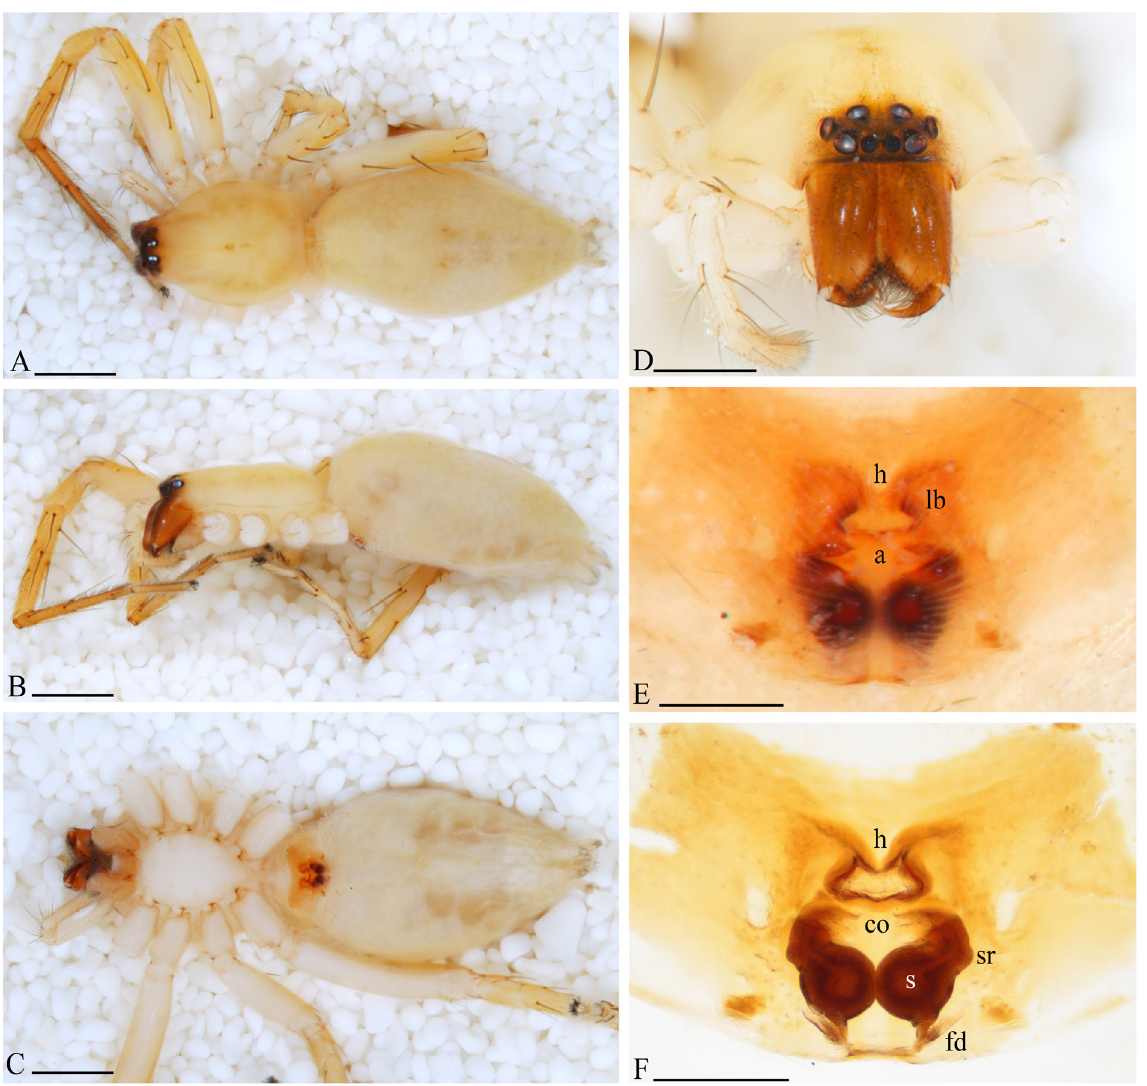
Fig. 37. Anyphaena noctua sp. nov., holotype, ♀ (CNAN-T01533). A . Dorsal habitus. B . Lateral habitus. C . Ventral habitus. D . Prosoma, anterior view. E . Epigynum, ventral view. F . Epigynum, dorsal view. Scale bars: A–C = 1.0 mm; D = 0.5 mm; E–F = 0.2